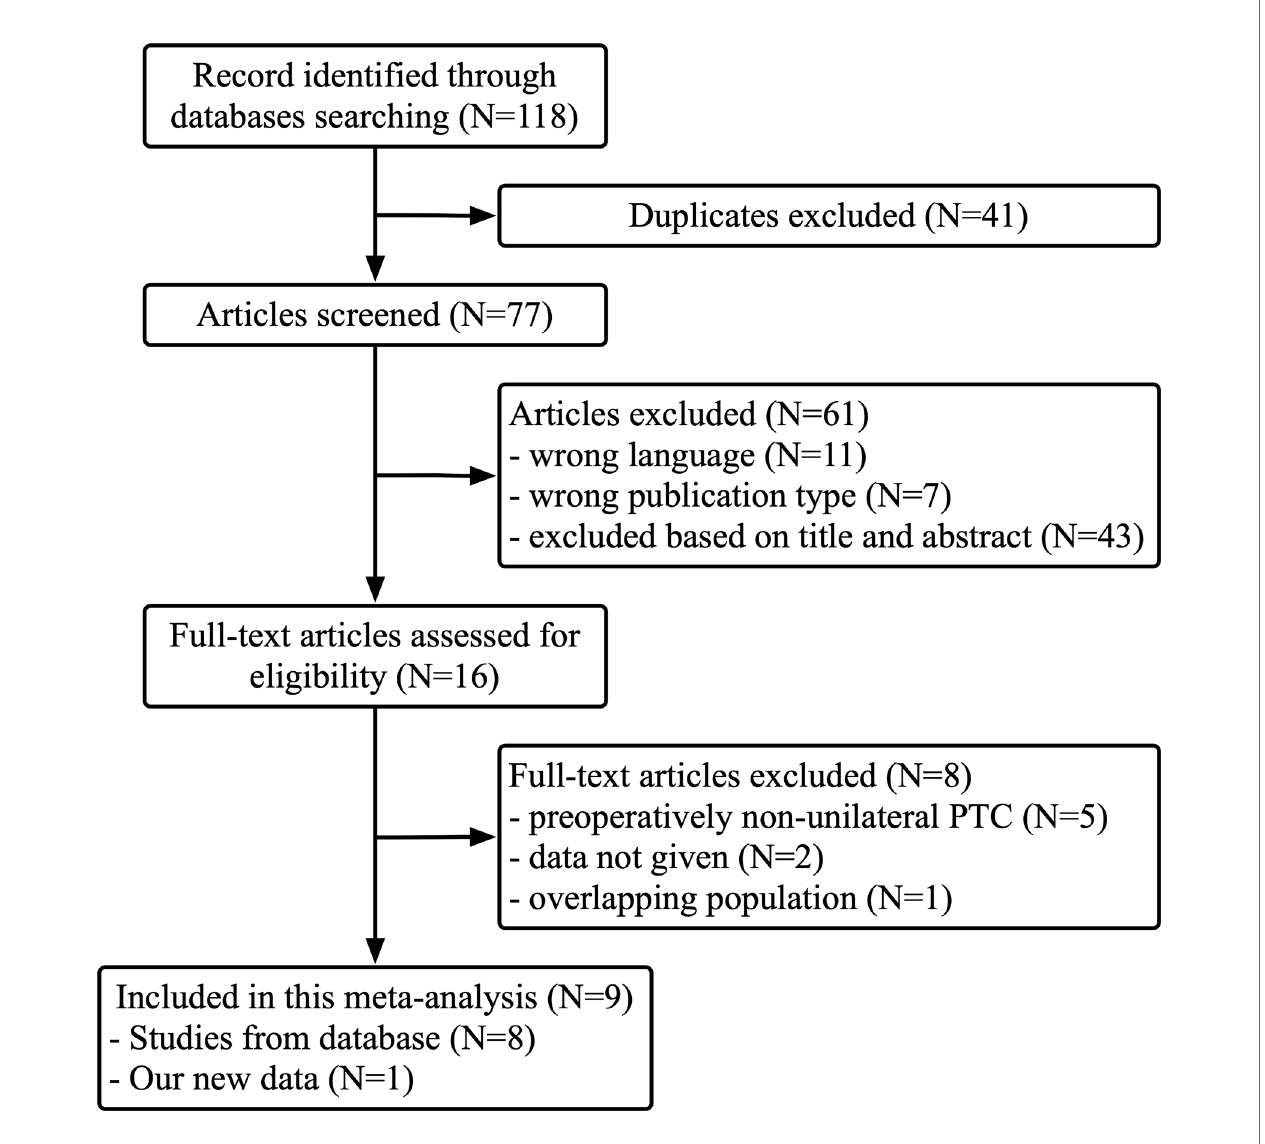
FIGURE 1 | Flow chart of the study selection